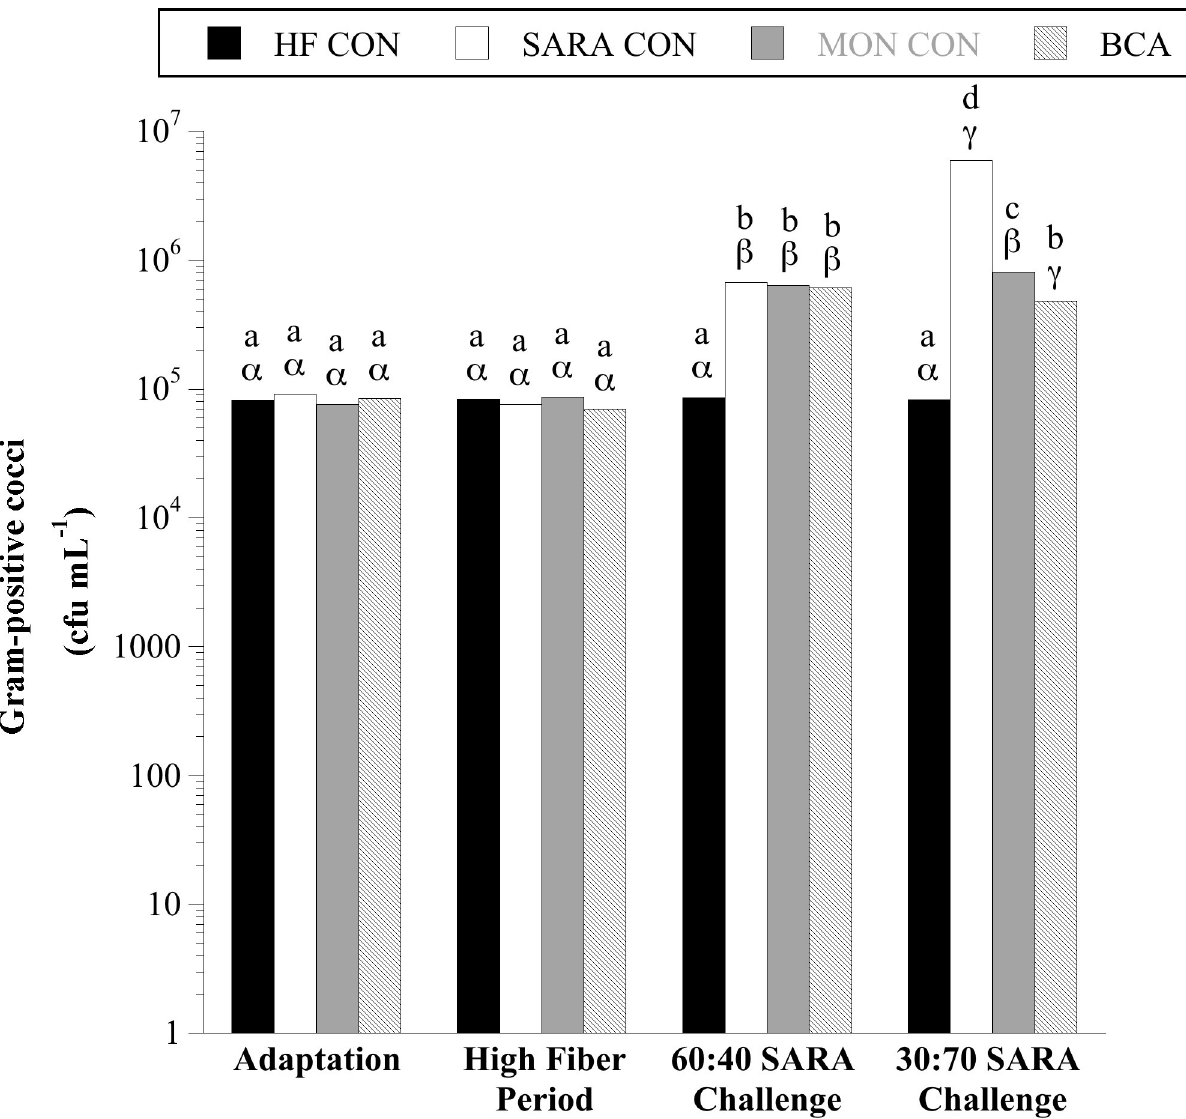
Fig 2. Effect of biochanin A on the viable number of Group D Gram-positive cocci (GPC; Streptococcus bovis , Enterococcus spp.) in rumen fluid (4 h post-feeding). Holstein steers (n = 12) were blocked by weight into 1 of 4 treatments: High fiber control (HF CON; basal diet control, corn silage + dried distillers’ grain, to meet protein requirements; n = 3), SARA control (SARA CON; n = 3), SARA + monensin treatment (MON CON; 200 mg d -1 monensin; n = 3), or SARA + biochanin A treatment (BCA; 6 g d -1 biochanin A; n = 3). Rumen fluid samples were taken at the end of the adaptation period (100% basal diet), high fiber period (100% basal diet + treatments), 60:40 SARA challenge period (60% basal diet + 40% cracked corn + treatments), and 30:70 SARA challenge period (30% basal diet + 70% cracked corn + treatments) for GPC bacterial enumeration. GPC were enumerated on bile esculin azide agar (BD). The plates were incubated aerobically (39˚C, 3 d). Plates with 30 < x < 300 colonies were counted. Black colonies on bile esculin azide agar were counted as GPC. Means lacking a common English letter are different within sample day ( P < 0.05). Means lacking a common Greek letter are different over sample days within treatment ( P < 0.05). Treatment: P < 0.0001, sample day: P < 0.0001, and treatment × sample day: P < 0.0001; Pooled SEM: Treatment = 0.0156, sample day = 0.0192, treatment × sample day = 0.0385 (log